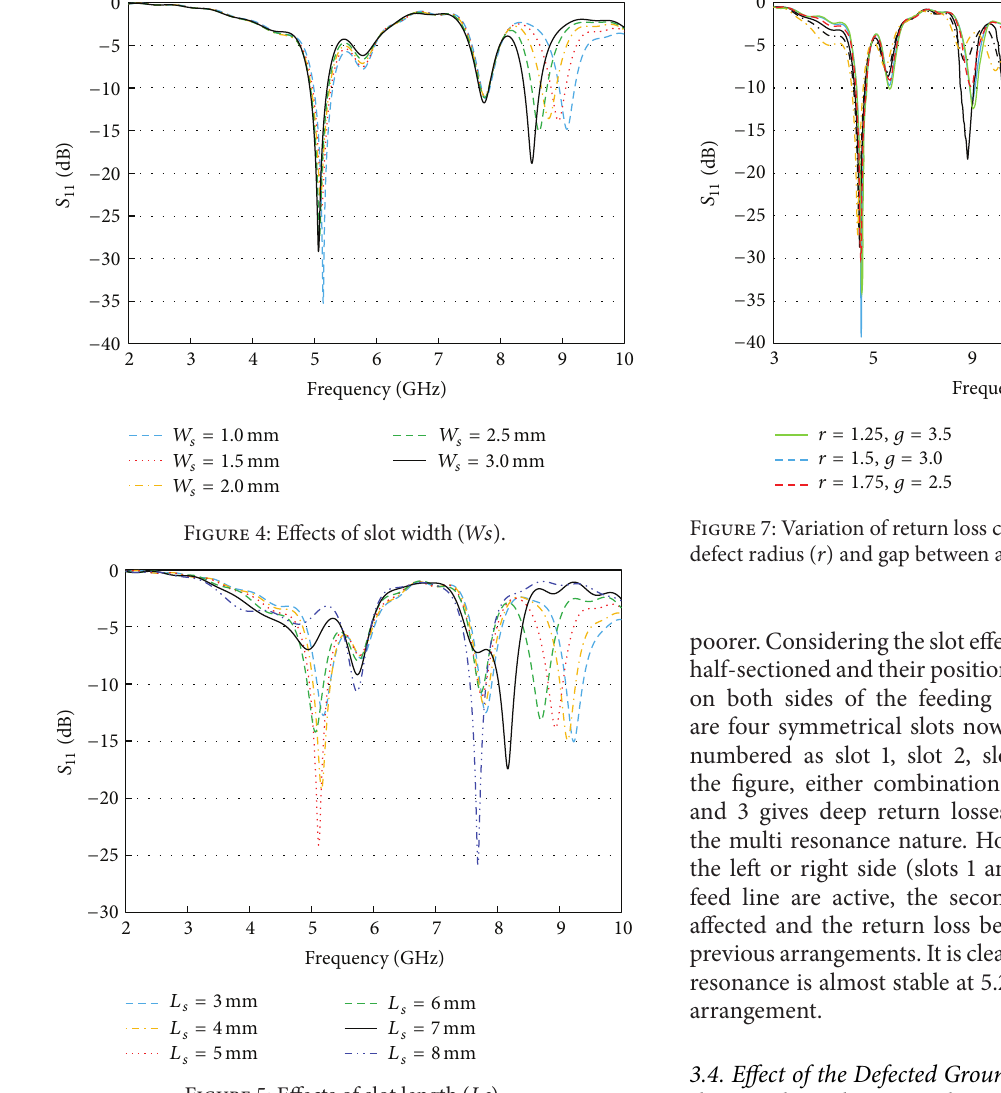
Figure 5: Effects of slot length (𝐿𝑠) .